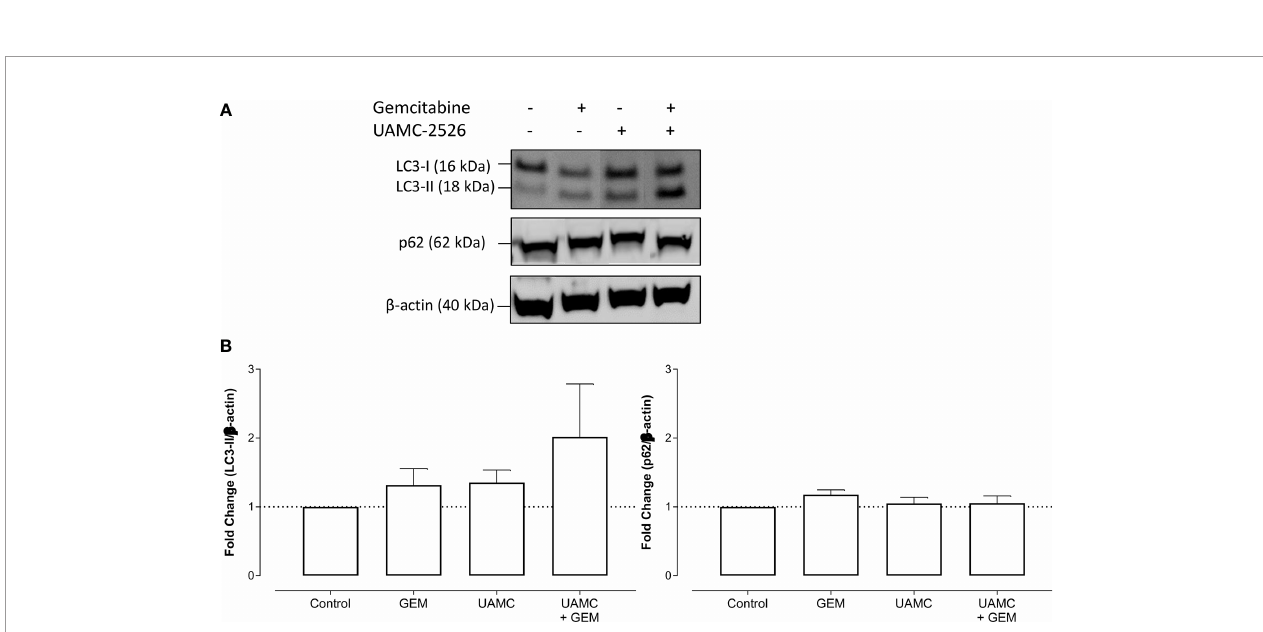
FIGURE 10 | UAMC-2526 has no impact on autophagy in Panc02 tumors. (A) C57/BL6 mice with Panc02 tumors were treated with vehicle (control), UAMC-2526 (UAMC), gemcitabine (GEM) or a combination of UAMC-2526 and gemcitabine. After treatment, western blots were performed on Panc02 tumor lysates to detect LC3-II and p62. b -actin served as a loading control. Representative images are shown. (B) Quanti fi cation of LC3-II and p62 relative to b -actin. Data were analyzed using one-sample t-test. After normalization, the resulting fold change was log transformed (log2-base) to obtain an approximately normal distribution. Number of animals in each group was between 8-10. No signi fi cance was